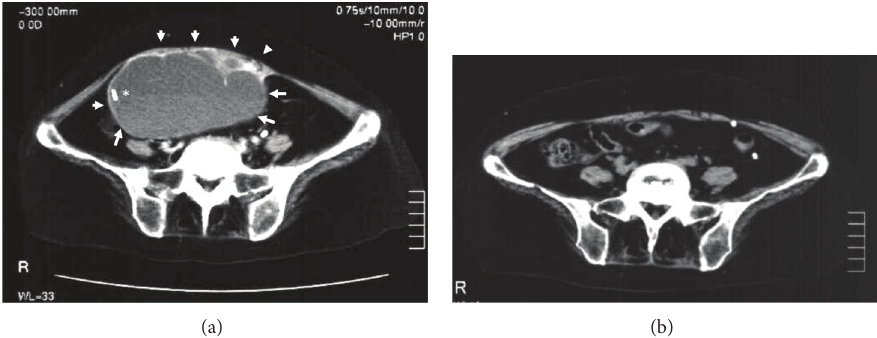
Figure 2: Preoperative abdominal CT scan image with contrast medium (a) showing a huge multilocular cyst-like enhanced mass (arrowheads) in the peritoneal space around the distal tip of the VP shunt tube ( ∗ ). An abdominal CT image that was performed 2 months after the laparotomy (b) indicating no recurrence of the